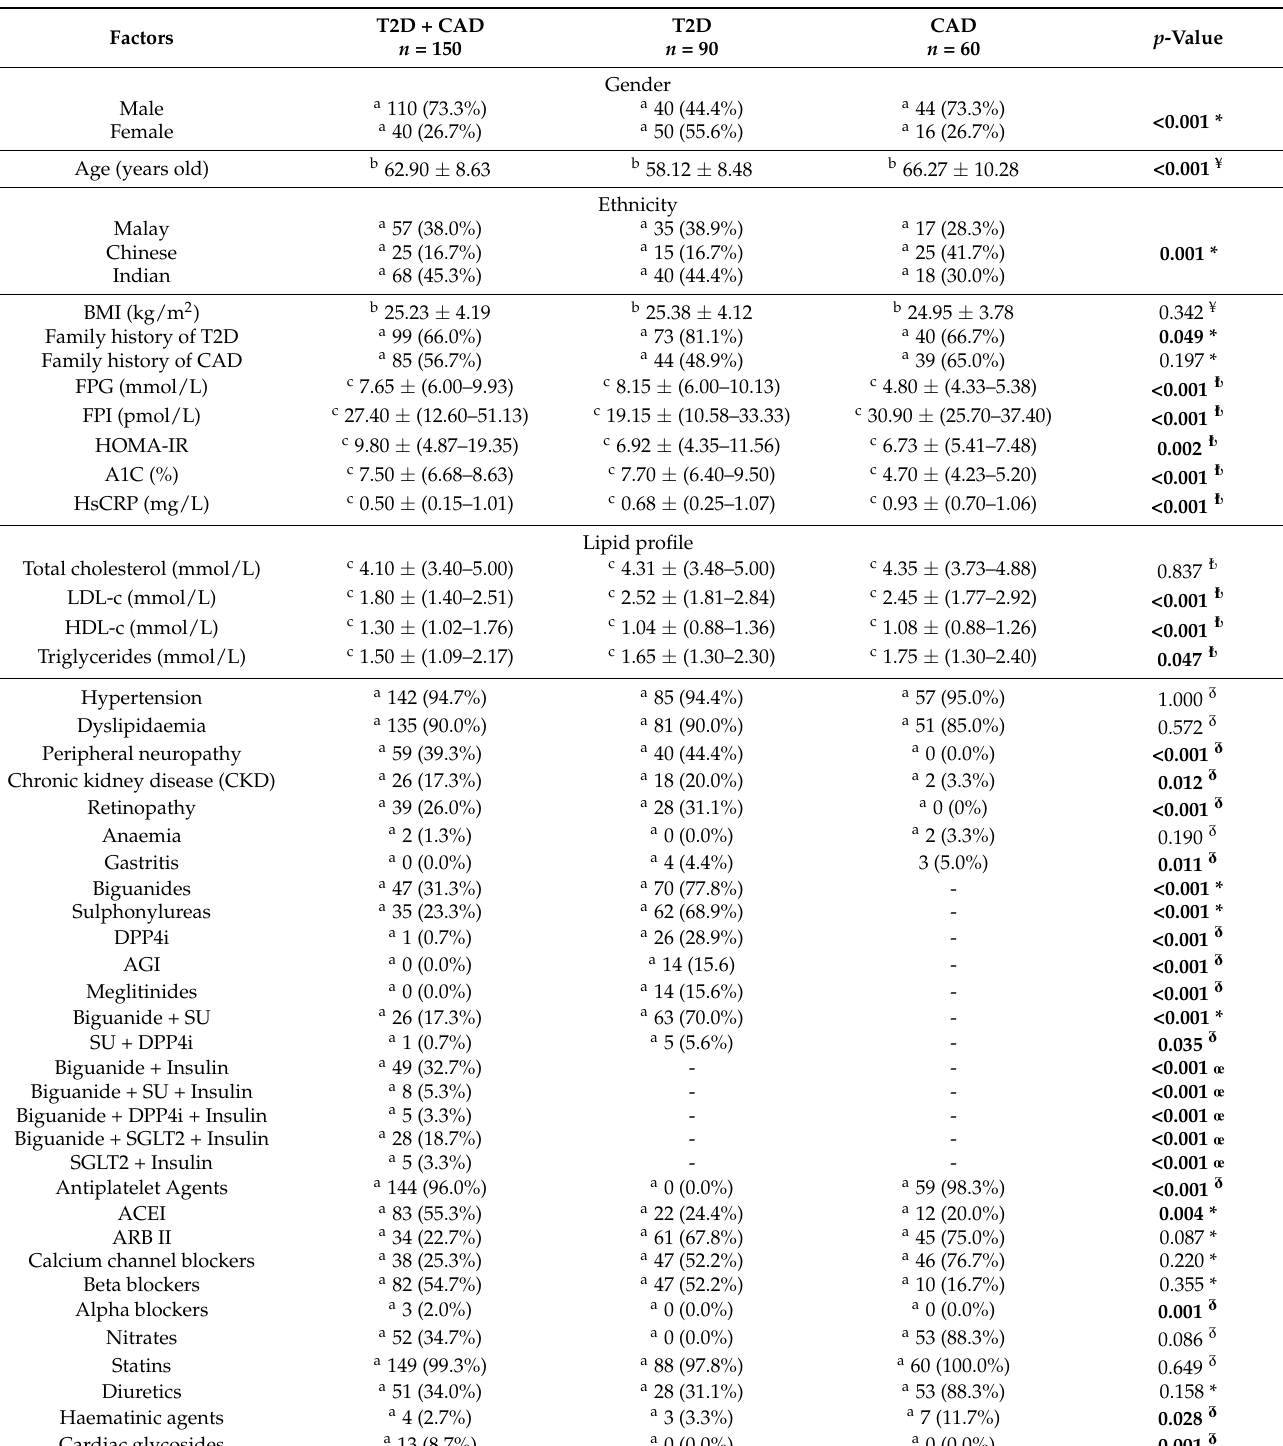
Table 2. Demographic and clinical factors of the study population ( n = 300).